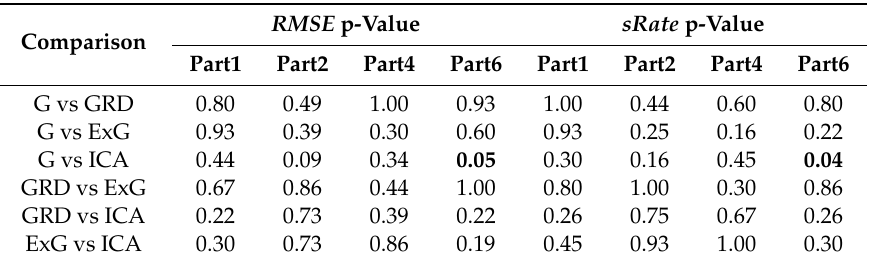
Table A7. The Wilcoxon rank sum test results (p-values) for comparing di ff erent signal extraction methods and activities, algorithm No.1 (PSD).